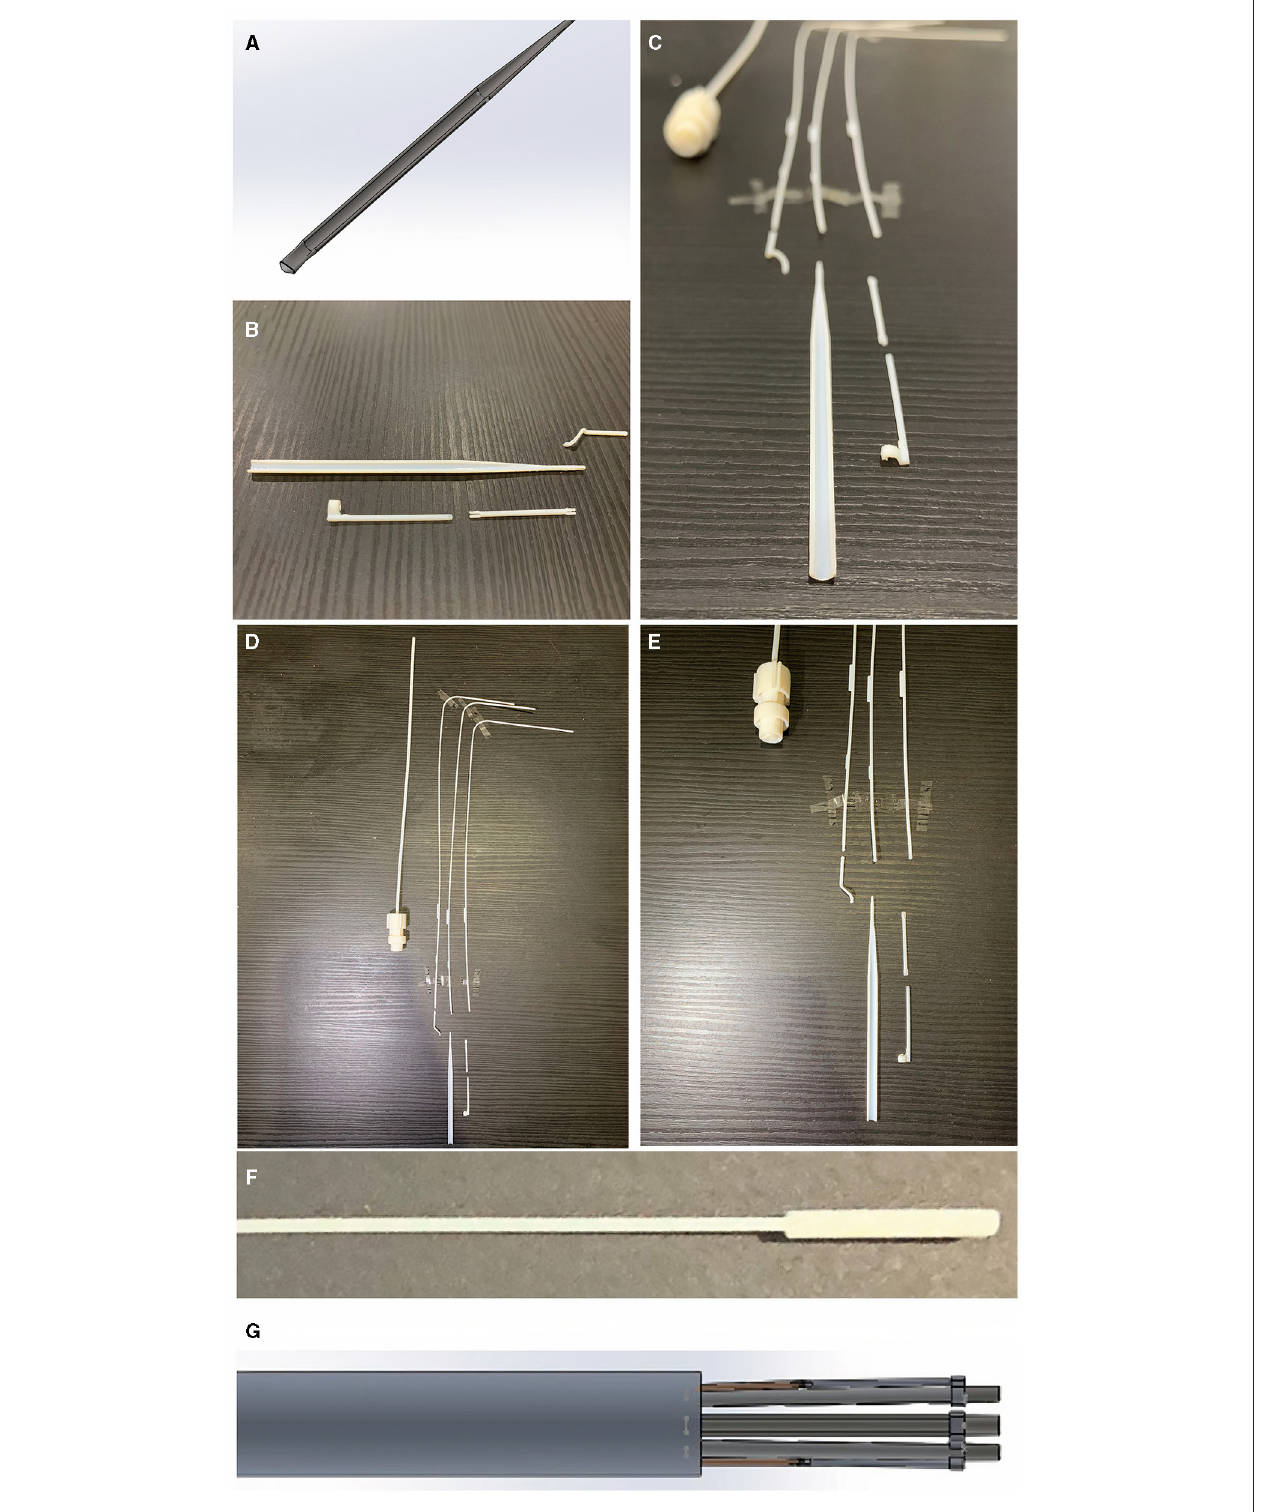
FIGURE 4 | Curved edges of the arm to reduce risk of injury to surrounding structures inside the chest. (A) Shows the CAD blueprint for the main component of one of the arms. The photographs in (B,C) show the same curved edged arm with surrounding component parts after the sizing and learning resin print (VeroVivid and Agilus). These parts were reproduced with a high degree of accuracy to the blueprint and the surrounding component parts fitted with the main body of the arm. This